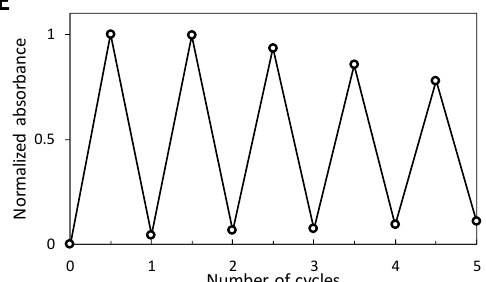
Figure 2. ( A ) Acid- and base-induced structural conversion between ins -SP-PPE and ins -MCH + -PPE. ( B ) Ultraviolet-visible (UV-Vis) spectroscopy spectra of ins -SP-PPE (2.0 × 10 − 5 M in CH 2 Cl 2 ) upon addition of different amounts of trifluoroacetic acid (TFA) (0–0.2 M). ( C ) A change of normalized absorbance of ins -SP-PPE at 420 nm under the addition of TFA (0–0.2 M). ( D ) UV-Vis spectra of ins -SP-PPE (2.0 × 10 − 5 M in CH 2 Cl 2 ) upon addition of different amounts of triethylamine (TEA) (0–0.2 M) following the TFA addition (0.2 M). ( E ) Repeatable switching of the absorbance of ins -SP-PPE (2.0 × 10 − 5 M in CH 2 Cl 2 ) at 420 nm by the addition of TFA and TEA.